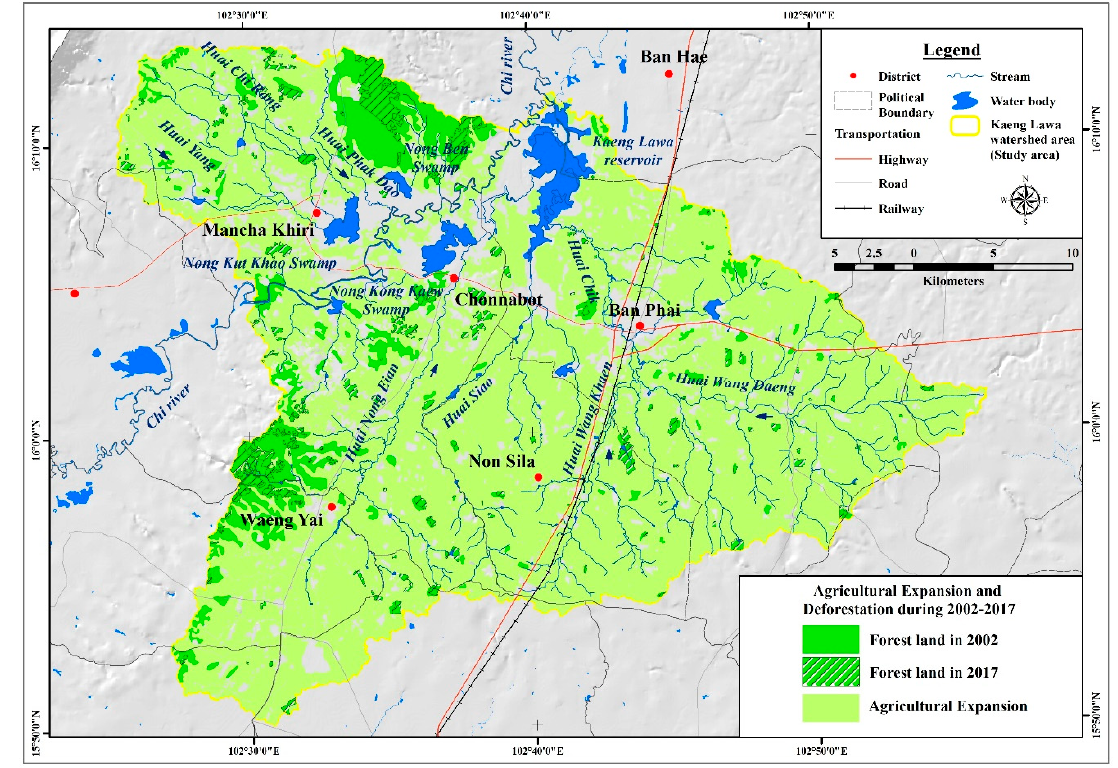
Figure 9. The expansion of agricultural areas and deforestation during 2002–2017 in KLs area, Khon Kaen Province.